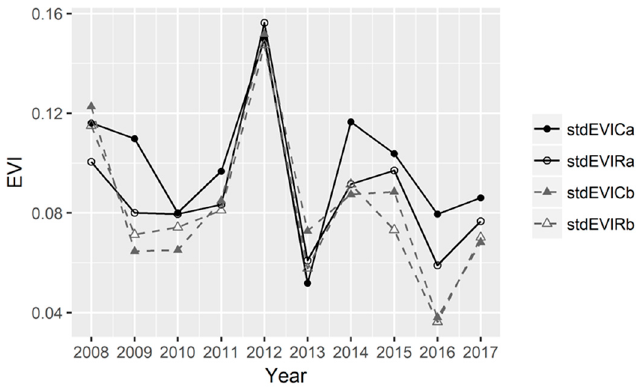
Figure 7. Growing season standard deviation of EVI from Landsat 7 for different treatments.